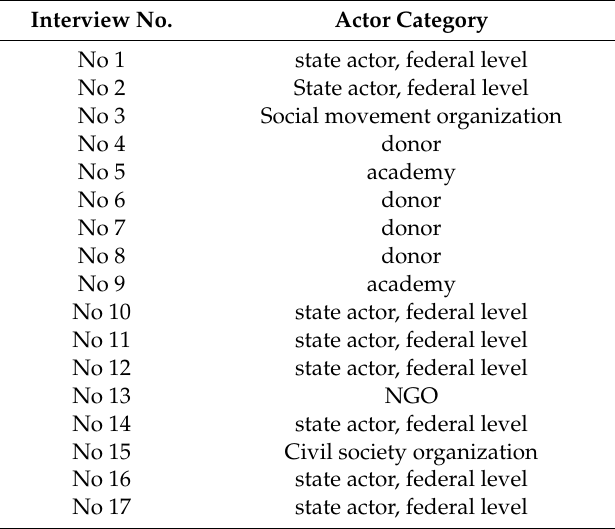
Table A1. List of interview partners by actor